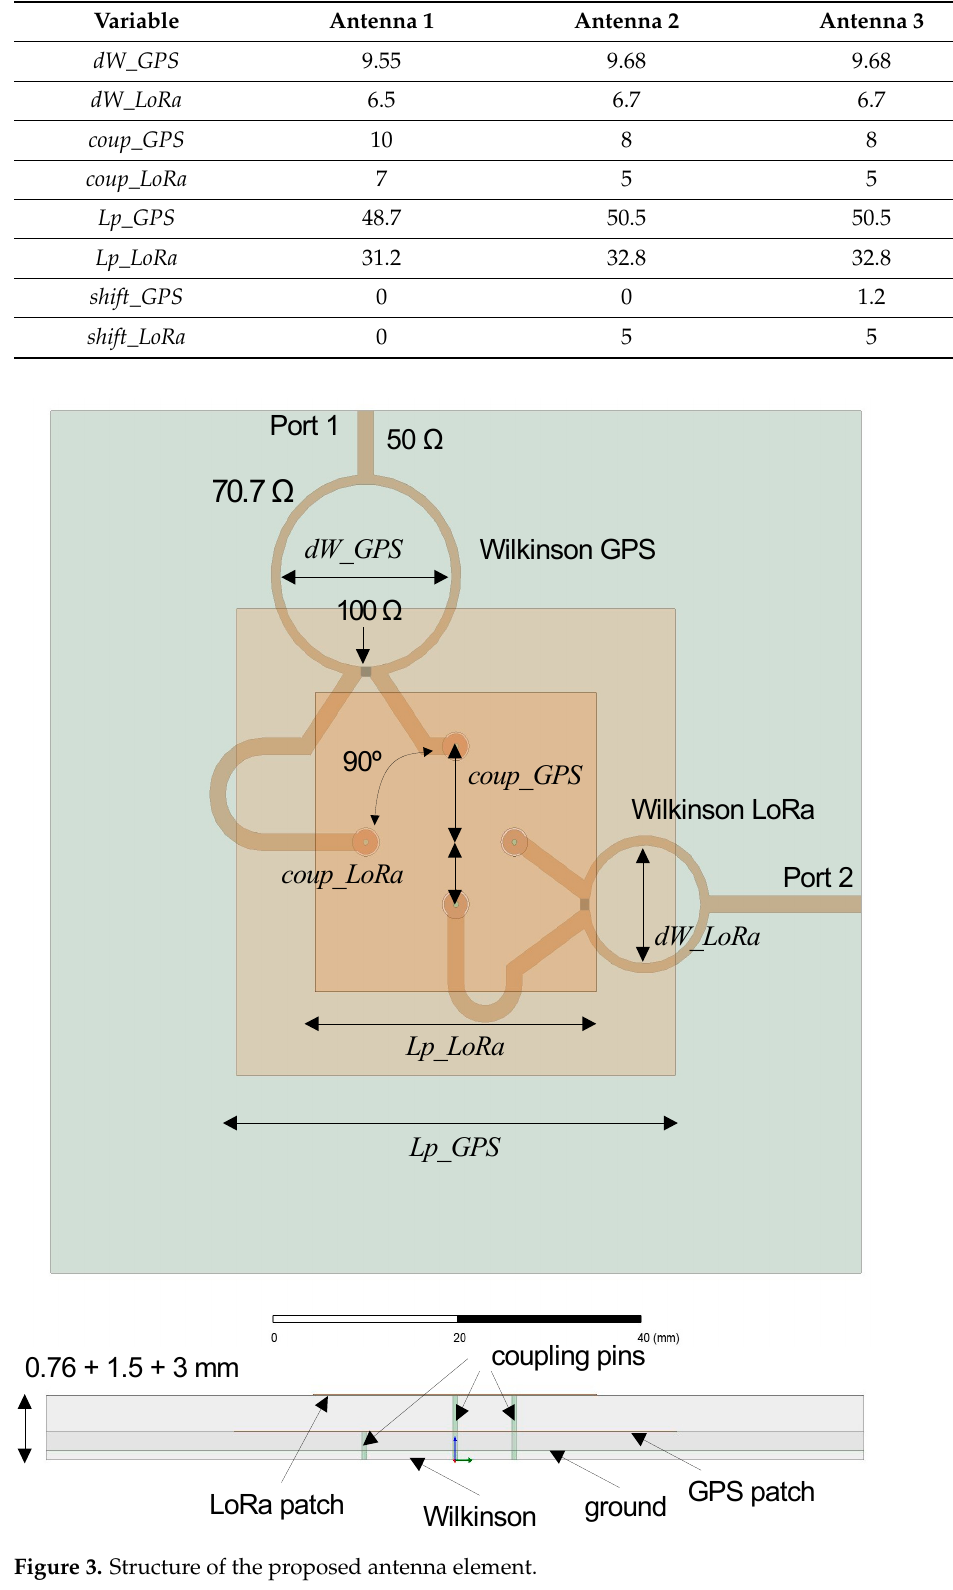
Figure 3. Structure of the proposed antenna element.